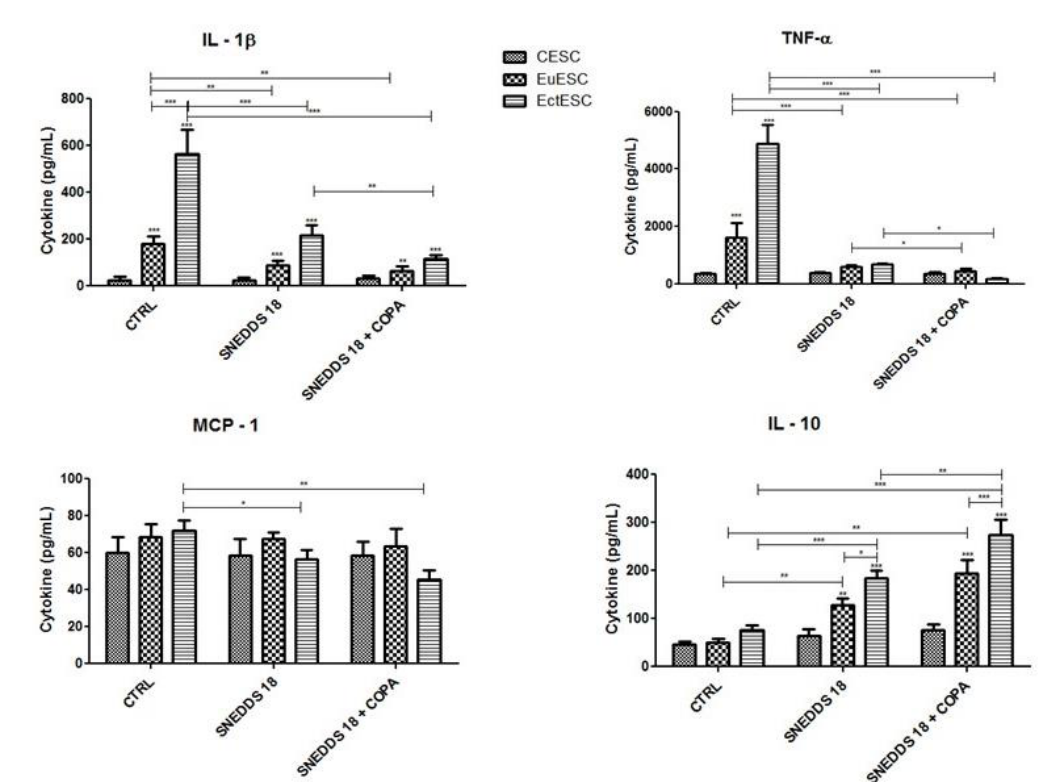
Figure 9. Production of cytokines by CESC, EuESC, and EctESC cells after treatment with nanoemul- sions. After 24 h of incubation with nanoemulsions (50 µg/mL), supernatants were collected to measurement of indicated cytokines. Results are expressed as mean ± SD ( n = 9). * p < 0.05; ** p < 0.01; *** p < 0.001 when comparing CESC-, EuESC-, and EctESC-nanoemulsion-treated groups with vehicle- treated group. CESC: Endometrial stromal cells obtained from topic endometrium of patients without endometriosis; EuESC: Endometrial stromal cells obtained from topic endometrium of endometriosis patients; EctESC: Endometrial stromal cells obtained from ectopic endometrium of endometriosis patients (endometriotic lesions).